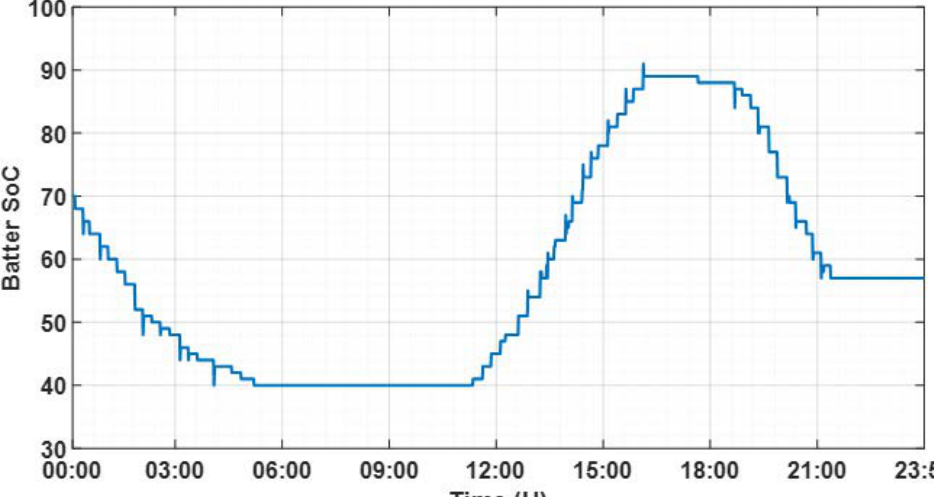
Figure 12. State of